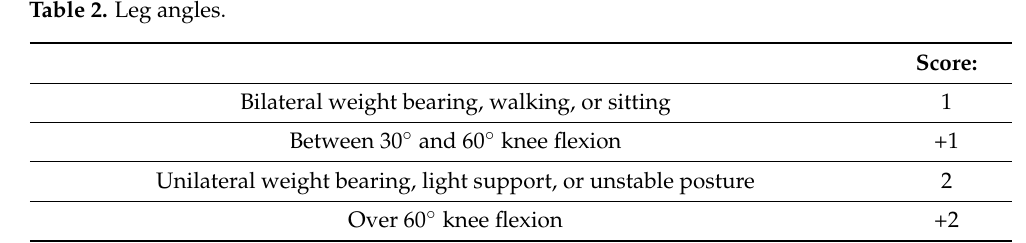
Score: Upright position (Vertical angle close to 0 ◦ ) 1 Slightly bent position ( − 20 ◦ to 20 ◦ angle from the vertical line) 2 Bent–flexion (20 ◦ to 60 ◦ forward angle) or extension ( − 20 ◦ backward angle) 3 Very inclined position (flexion over 60 ◦ ) 4 When accompanied by twisting or lateral flexion of the trunk, the score increases by +1 one unit.